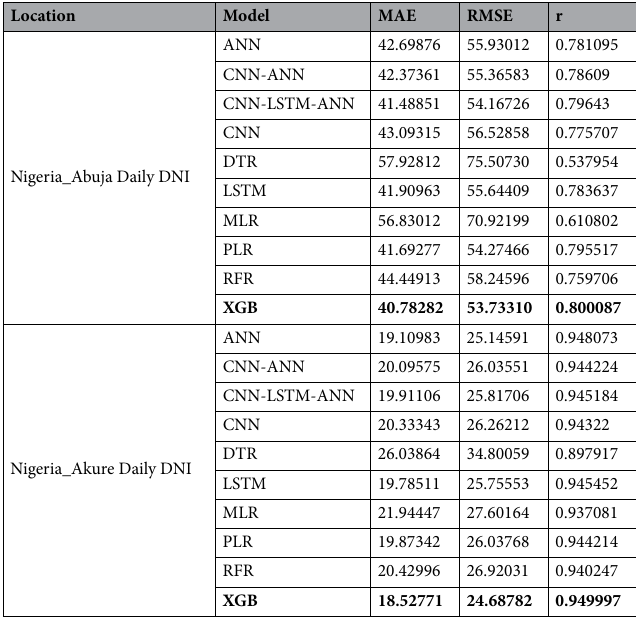
Table 5. Daily DNI task evaluation metric summary. Significant values are in